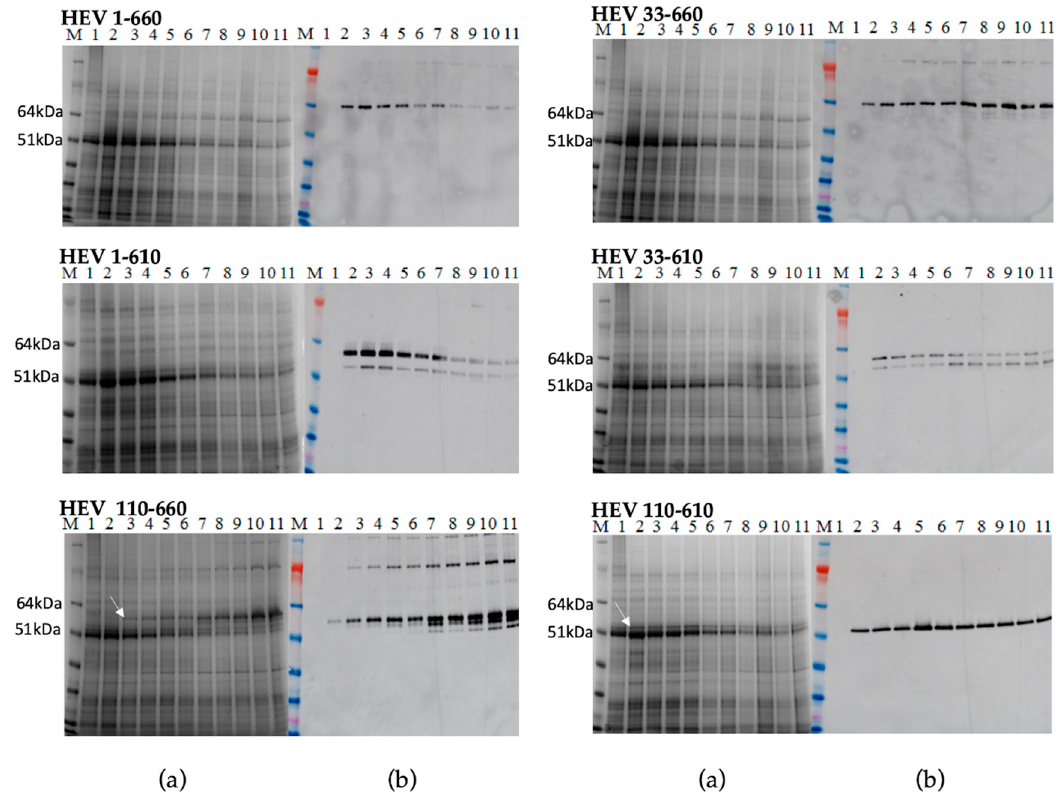
Figure 2. Transient expression of all constructs. Samples were collected day 2–11 post infiltration and analysed on SDS-PAGE gel ( a ) M. Molecular weight marker (kDa); 1. Leaves inoculated with the empty pEAQ- HT vector; 2–11 Protein samples extracted using TCA method from inoculated plant from day 2 pi to day 11 pi; ( b ) Western blot using anti-HEV ORF2 mAb, the samples are in the same order.